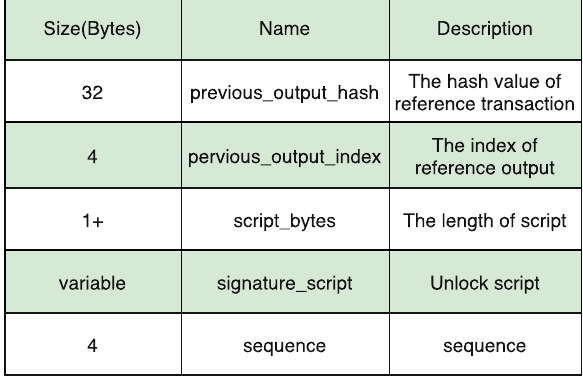
Fig. 2 Structure of transaction